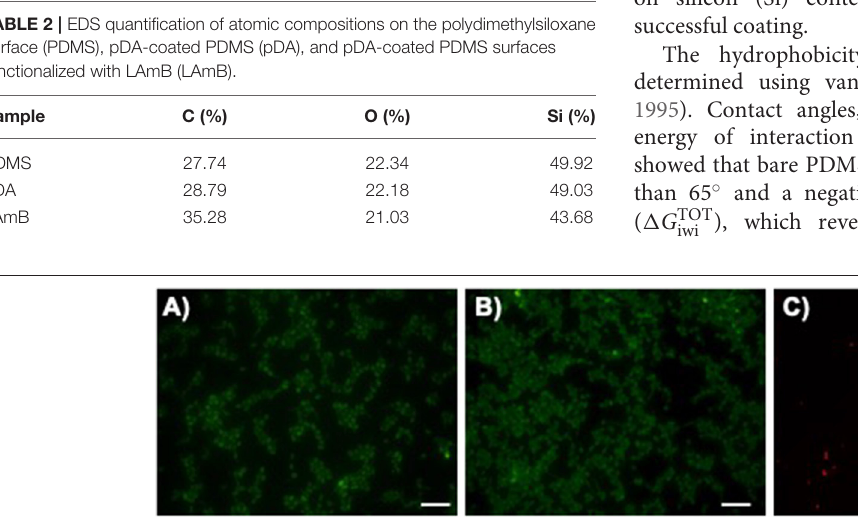
FIGURE 3 | Fungal initial adhesion to surfaces. Representative fluorescent live/dead stain images obtained after adhesion of C. albicans for 4h on unmodified polydimethylsiloxane (PDMS, (A) , pDA-coated PDMS surfaces (pDA, (B) and pDA-coated surfaces functionalized with LAmB (LAmB, (C) . The scale bar indicates 20 µ